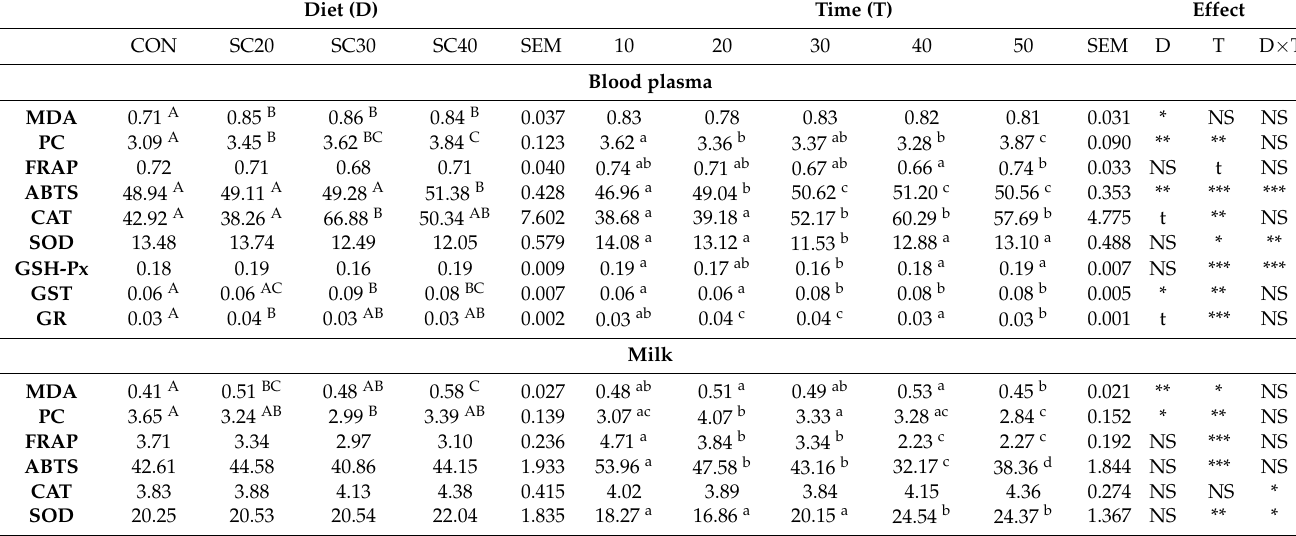
Table 4. Enzyme activities (Units/mL), total antioxidant capacity and oxidative status biomarkers in blood plasma and milk of ewes fed diets (CON, SC20, SC30, SC40) with different levels of Schizochytrium spp. microalgae (20, 30 and 40 g) throughout the experimental period (10, 20, 30, 40, 50 experimental